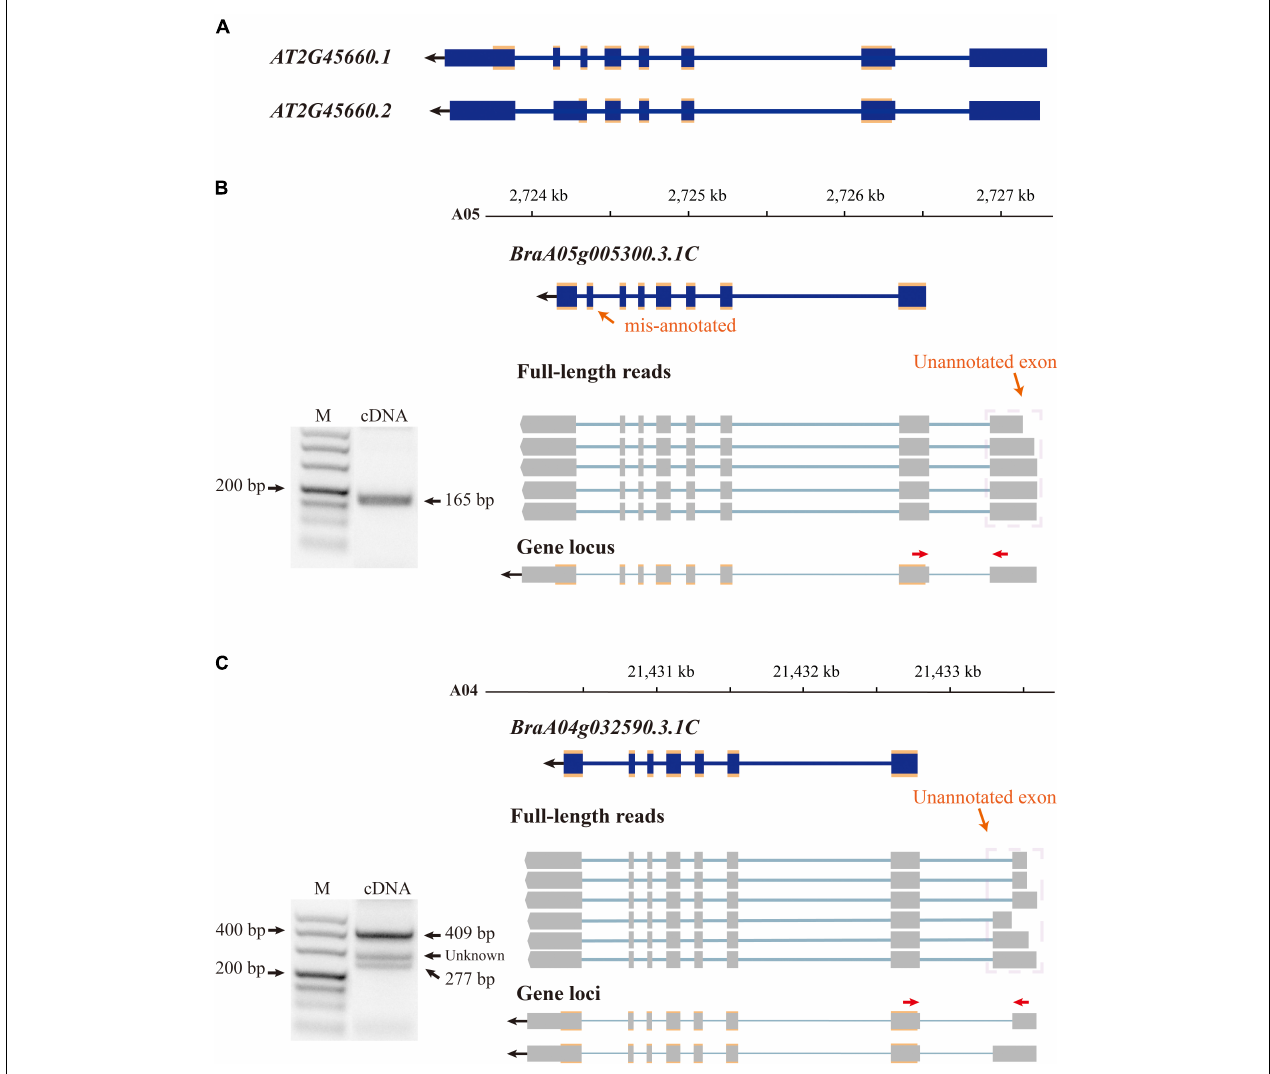
FIGURE 2 | Improving gene annotation by Iso-seq data. (A) The gene structure of SOC1 in Arabidopsis thaliana (Araport11). The blue boxes indicate exon and the croci boxes indicate the CDS of AtSOC1 . (B,C) RT-PCR validation of BrSOC1.1 ( BraA05g005290.3.5C ) and BrSOC1.2 ( BraA04g032780.3.5C ) structure. Forward and reverse primers are shown as red arrows. The schematic representation of genes and full-length reads is shown. The gene structure of the previously annotated BrSOC1.1 and BrSOC1.2 (blue) and the transcripts detected by Iso-Seq (gray). The gene locus shows BrSOC1.1 and BrSOC1.2 structures in v3.5; the blue and gray boxes indicate exons and the croci boxes indicate CDS. The PCR products of unknown length may indicate that the type was not